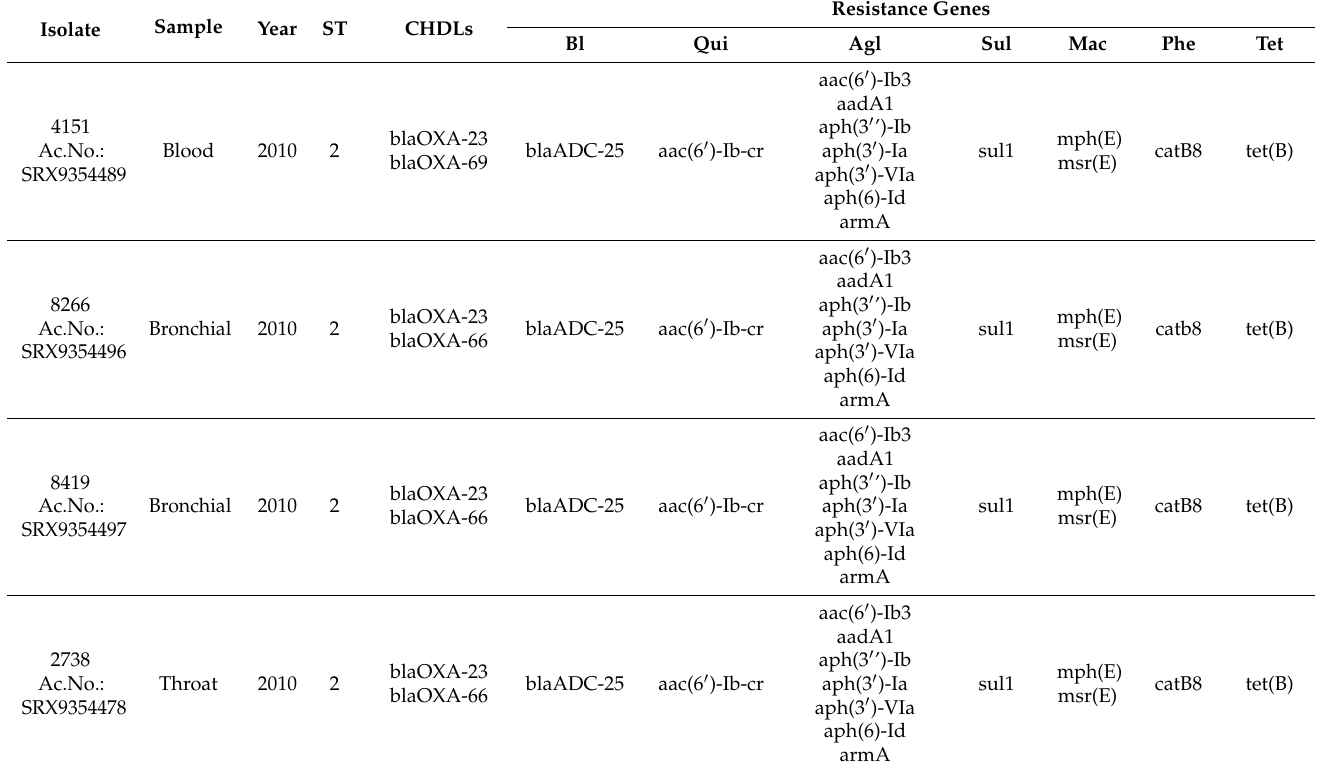
Table 1. Result of the whole genome sequencing of selected isolates and relationship between Acinetobacter baumannii sequence types and the antibiotic resistance genes carried. Ac.No. = accession number; ST = sequence type; CHDLs = class D β -lactamases; Bl = β -lactams; Qui = quinolones; Agl = aminoglycosides; Sul = sulphonamides; Mac = macrolides; Phe = phenicols; Tet =